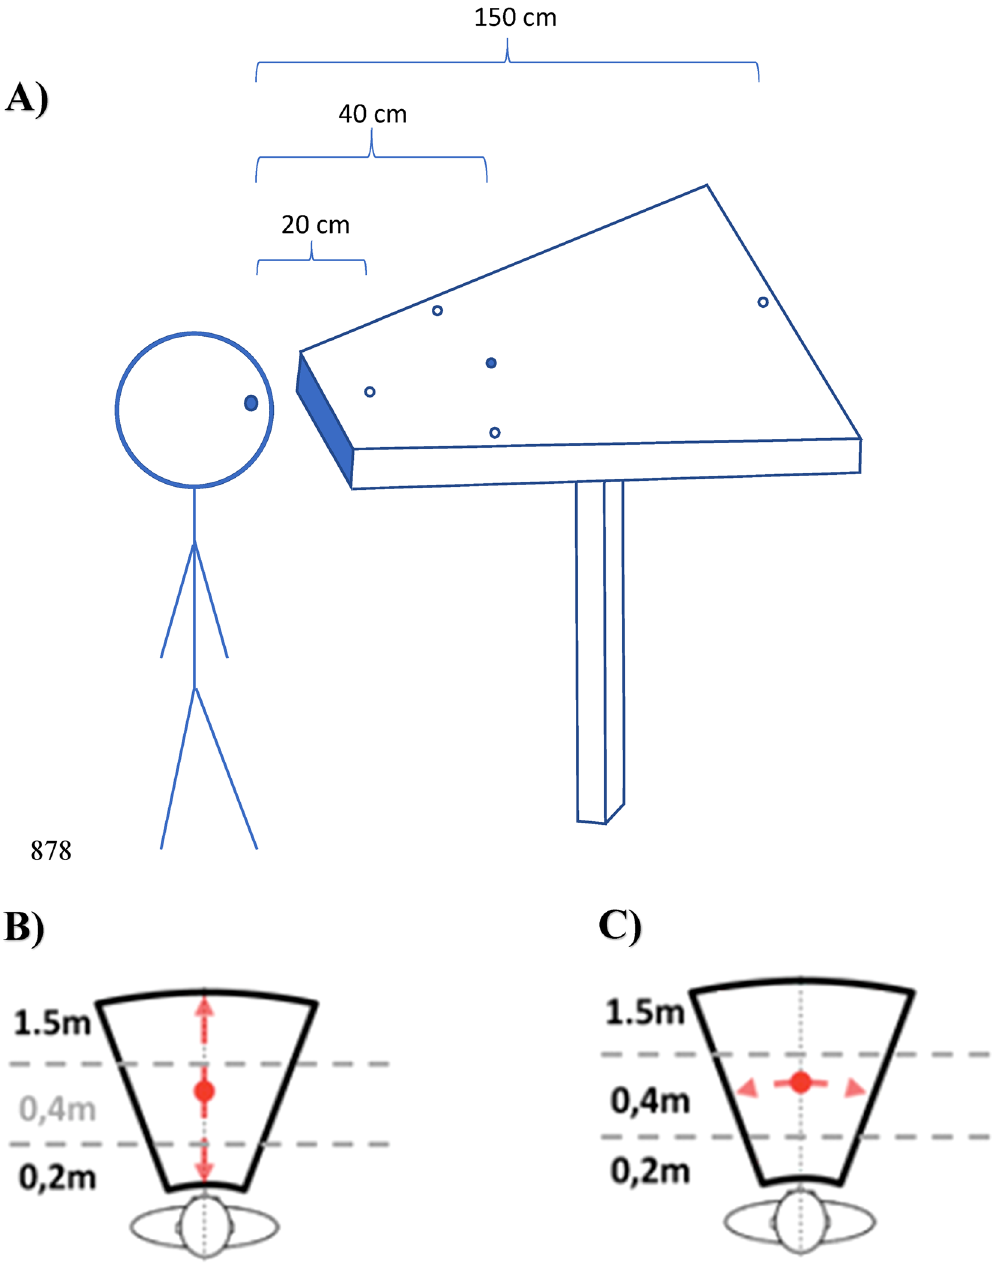
Figure 2. ( A – C ) Experiment set-up. Spatial ( A ) and temporal ( B , C ) arrangement of vergence and saccade tests. Subjects looked successively at different LEDs; from the initial (40 cm) fixation LED, to the target LED for divergence (150 cm) or the target LED for convergence (20 cm) ( B ); and from the initial (40 cm) fixation LED to the target LED for saccades (20° to left or right) ( C ). Each trial starts with the fixation target that appears for a variable period of 1200–1800 ms; following this period the target LED lights are on for 2000 ms together with a paired buzzer preceding 50 ms and lasting only 100 ms. ( C ) Arrows indicate the possible target locations for each